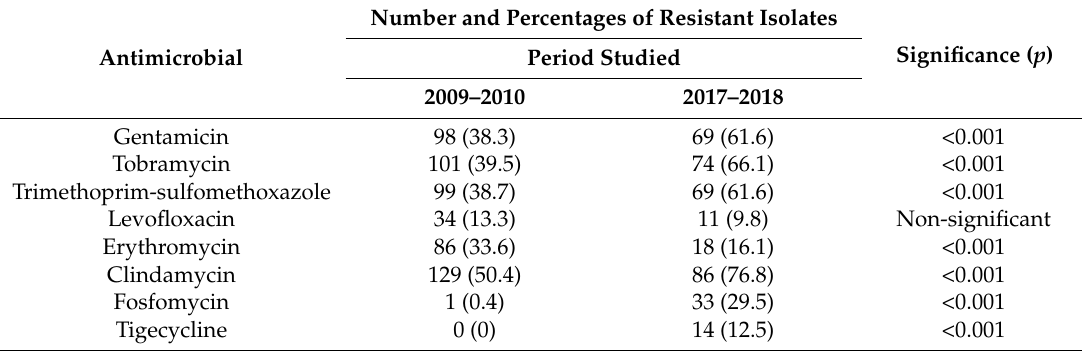
Table 1. Statistical significance of antimicrobial resistance according to period studied.